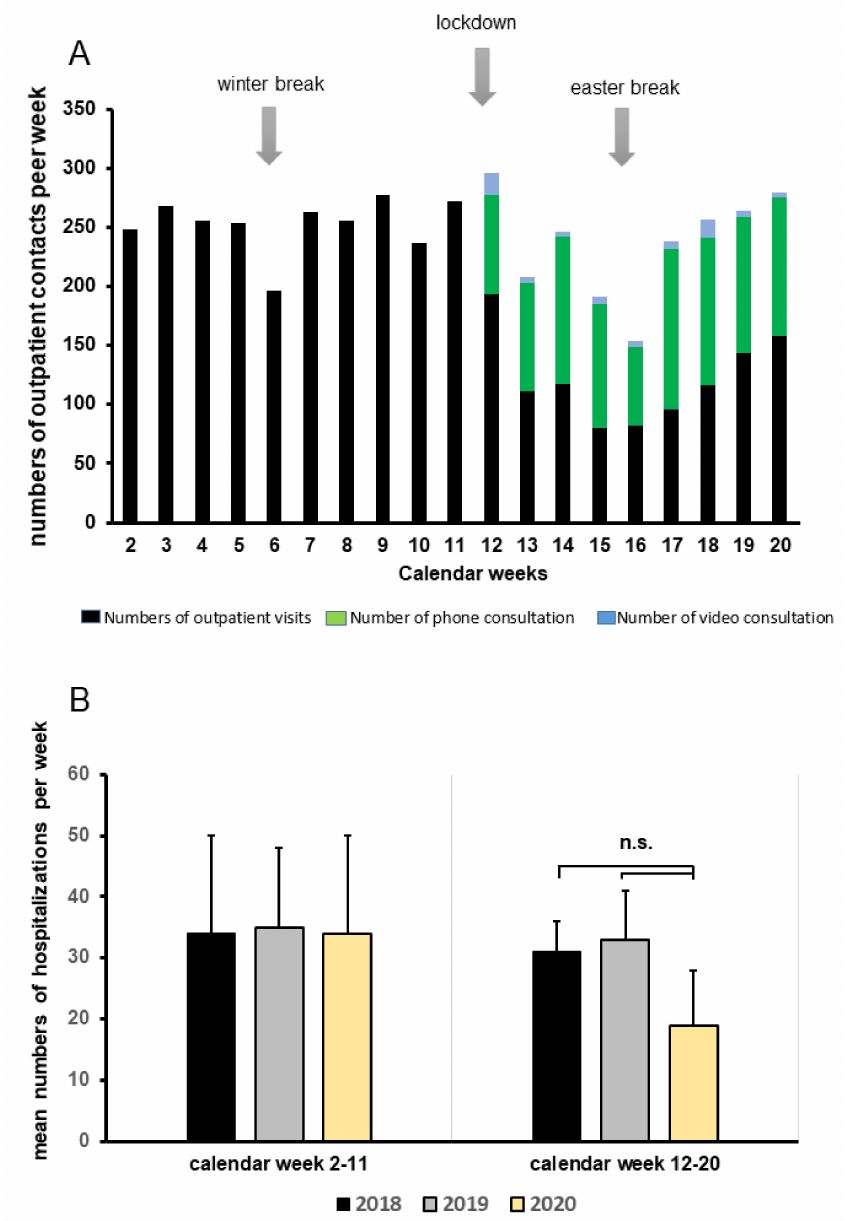
Figure3. Patientcare, alternativeteleconsultingfacilities, andhospitalizationratesduringtheCOVID-19 pandemic. ( A ) Number of outpatient contacts from January through May 2020 divided into outpatient visits, phone, or video consultations. ( B ) Mean numbers of weekly hospitalizations categorized into two time periods: calendar week 2–11 and 12–20 during 2018, 2019, and 2020 (yellow columns) compared to numbers in 2018 (black columns) and 2019 (grey columns); n.s. = not